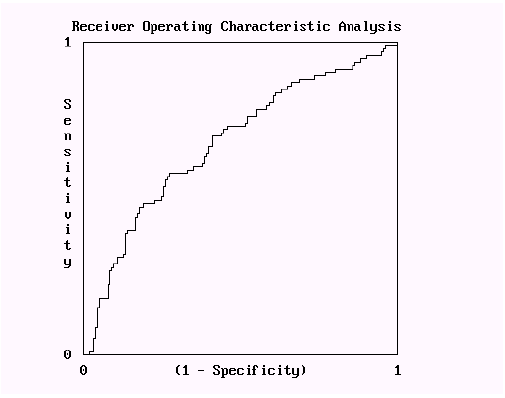
FIGURE 3B . ROC curve mortality within 90 days of discharge multilayer RBF. Test data: _____ AZ: